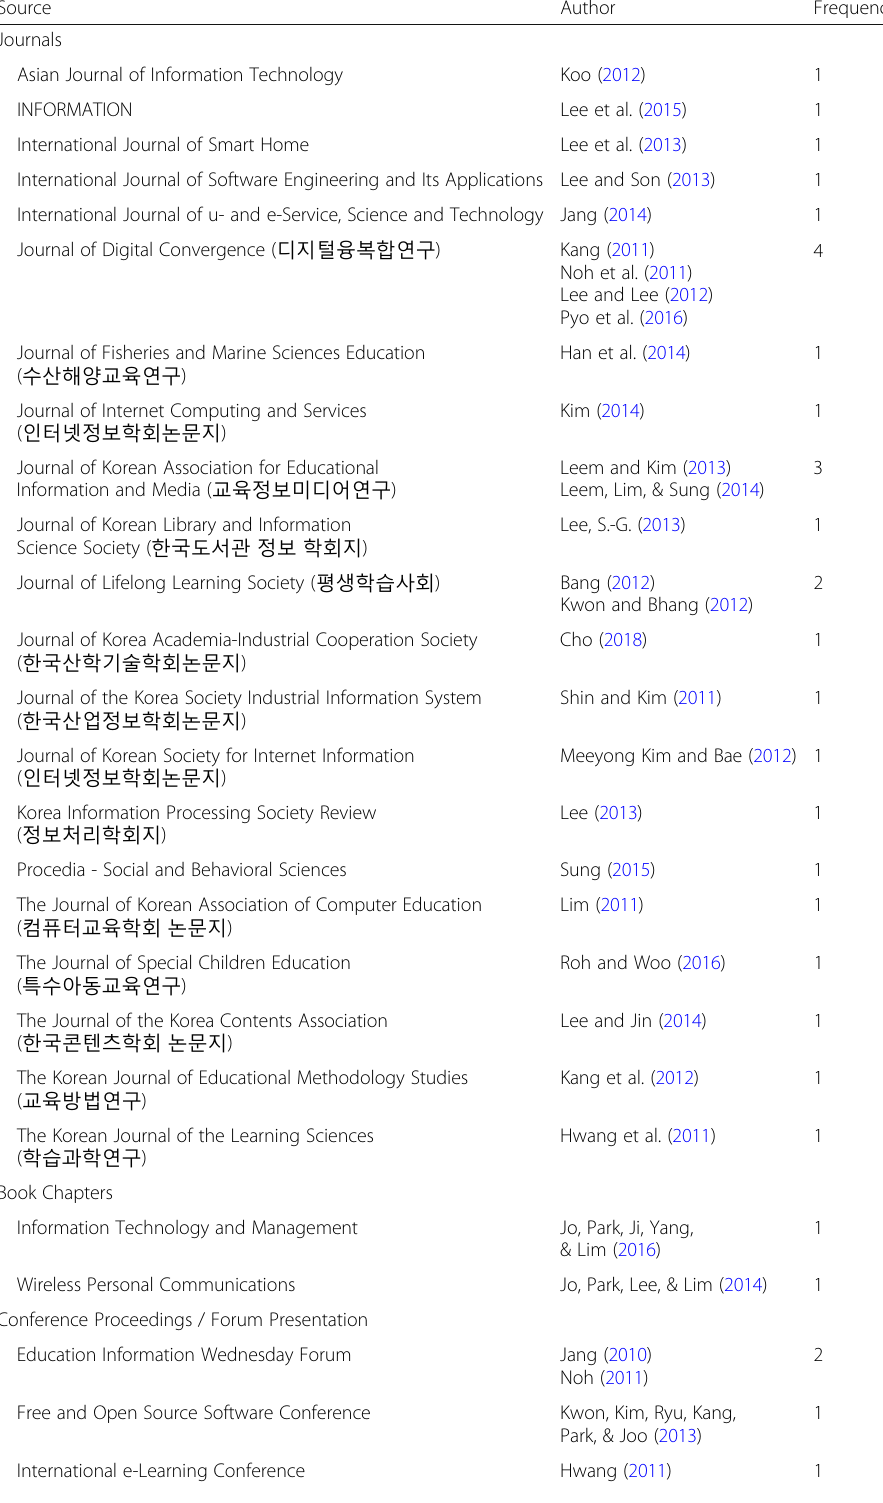
Table 2 Data sources listed by type, author, and